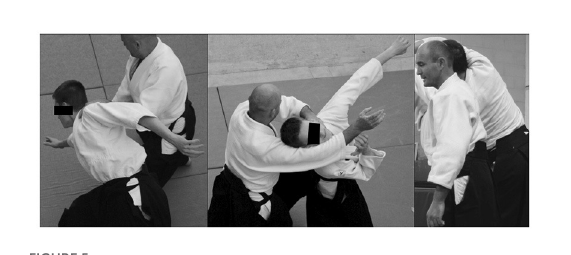
FIGURE5 Aikido: from Tori’s axis looking for the connection of Uke’s center generating twists and spirals in Uke’s spine. Jesús Arce (Black Belt 5 ◦ Dan) in